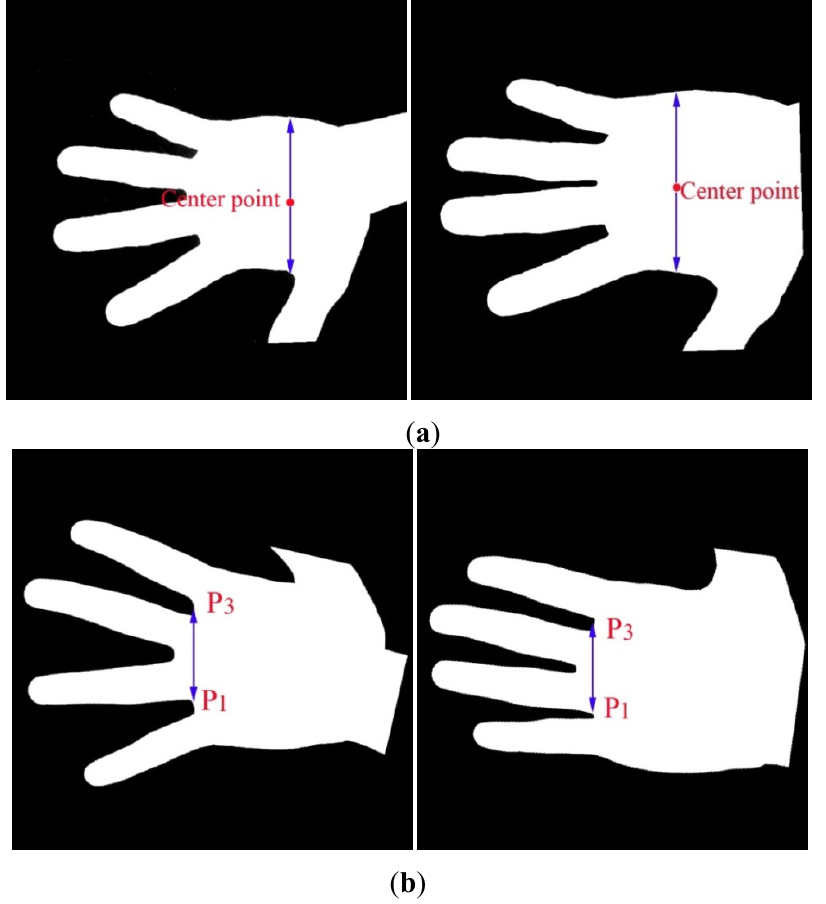
Figure 5. Two existing methods of calculating the palm width or ROI width, ( a ) Han’s method to estimate the palm width in the position of center point; ( b ) Michael’s method to estimate the size of ROI image using the distance between points P1 and